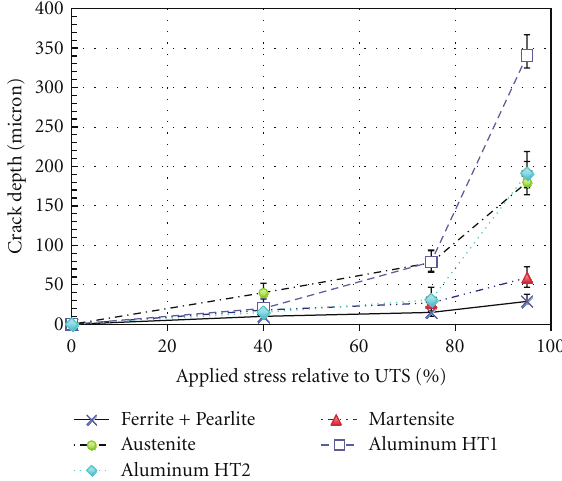
Figure 5: Crack depth as a function of applied stress.